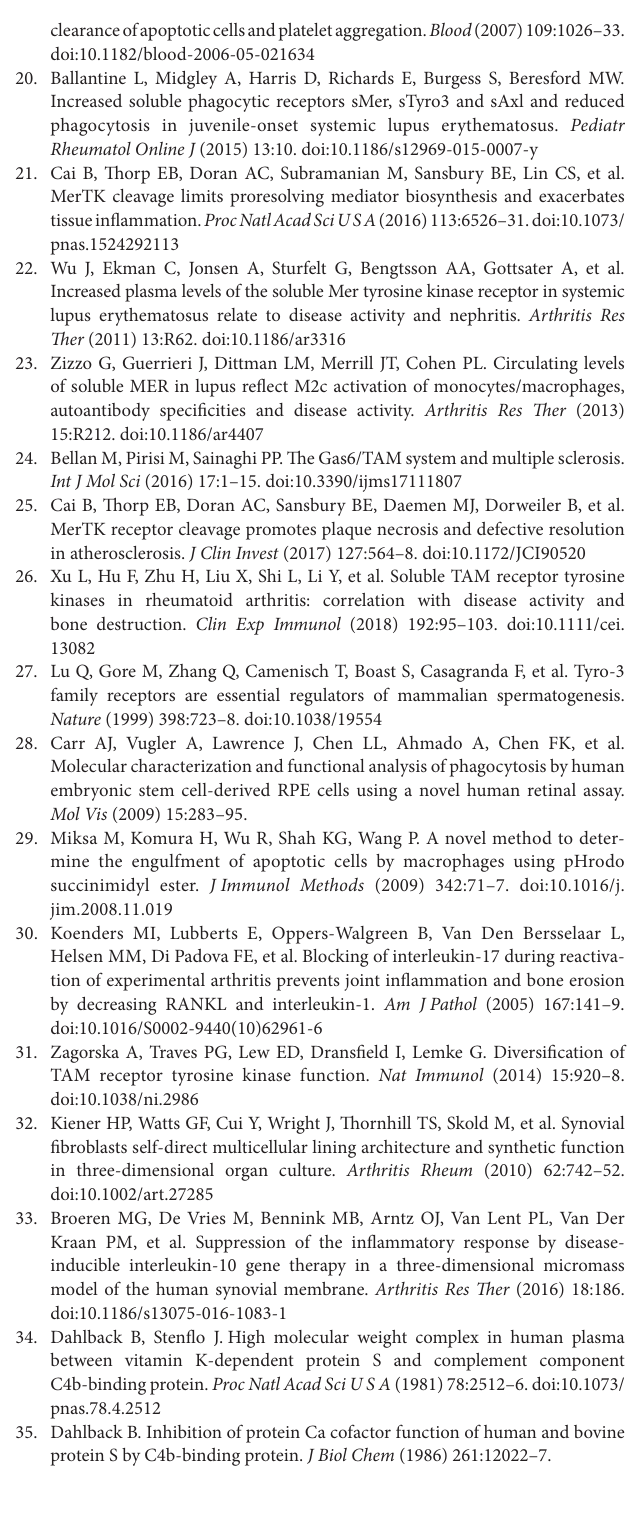
for the presence of soluble MER ( n = 4). (D) J774A.1 cells were incubated with IgG or anti-MER. Supernatants were examined for the presence of soluble MER ( n = 4). For (a) , data are presented as mean + SD. For (b–D) , data are presented as dot-plots with mean. For (a) , ** p < 0.01 with one-way ANOVA with Bonferroni post test. ND, not detected. See also Figure 5 and 6